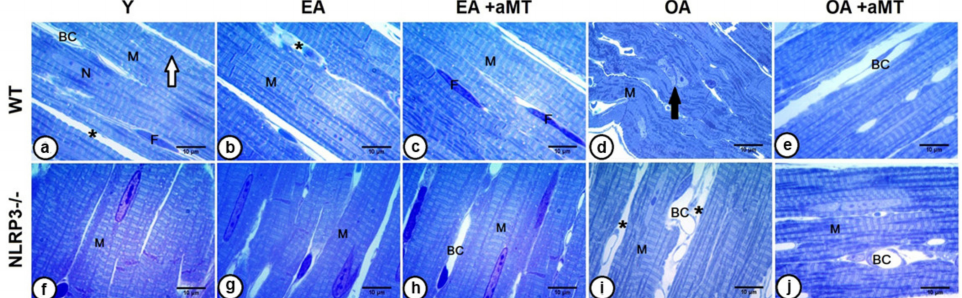
Figure 6. Effect of aging, NLRP3 deletion, and melatonin supplementation on morphological archi- tecture of cardiac muscle fibers. ( a ) Semithin left ventricle sections of young (Y) WT mice stained by toluidine blue stain showing normal cardiac muscle fiber (M) architecture, with centrally posi- tioned nucleus (N), and narrow interstitial spaces (asterisk) containing blood capillaries (BC) and fibroblasts (F). Note the intercalated disc (white arrow). ( b ) Cardiomyocytes (M) of early-aged (EA) WT mice revealing conservation of their striations with widening of interstitial spaces (asterisk). ( c ) The preservative effect of melatonin on maintaining normal cardiac fiber (M) architecture in EA animals. Numerous fibroblasts (F) were shown. ( d ) Cardiac muscle fibers of old-aged (OA) WT mice demonstrating disorganization of cardiomyocytes (M), loss of striation, and splitting of the nucleus (black arrow). ( e ) The protective effect of melatonin on conserving cardiac muscle fiber (M) orientation and striation in OA animals. ( f ) Left ventricle of Y NLRP3 − / − mice showing normal organization of the cardiomyocytes (M). ( g , i ) Cardiac muscle fibers (M) of the EA and OA NLRP3 − / − mice, respectively, revealing no structural changes, except increased interstitial tissues (asterisks) and blood capillaries (BC) in OA muscles. ( h , j ) Depicts the preservative effect of melatonin on cardiomy- ocyte (M) architecture in EA and OA NLRP3 − / − mice, respectively, revealing normal orientation and striation with narrow interstitial space containing blood capillaries (BC). Bar = 10 µ